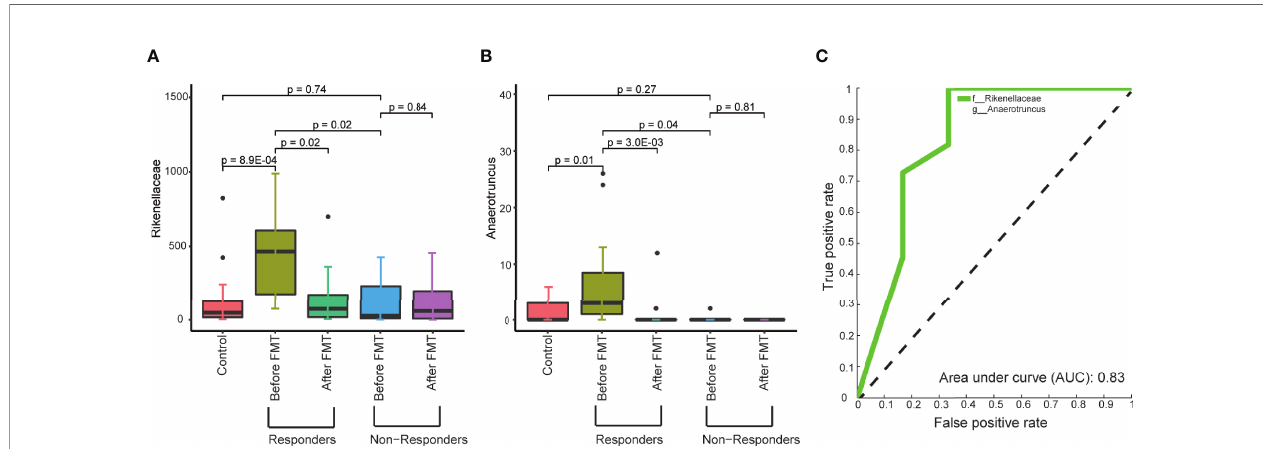
FIGURE 4 | The microbial abundance in pretreated fecal samples related to the response to FMT treatment. (A, B) Boxplots show the abundance of the family Rikenellaceae (A) and genus Anaerotruncus (B) in the fecal samples from control, responders, and nonresponders before and after FMT treatment. (C) ROC of the model trained to predict the response to FMT treatment based on the abundance of the family Rikenellaceae and the genus Anaerotruncus in pretreated fecal samples. The p-values within the responder and nonresponder groups were obtained by Mann – Whitney paired test, and p-values across groups were obtained by Mann – Whitney rank-sum